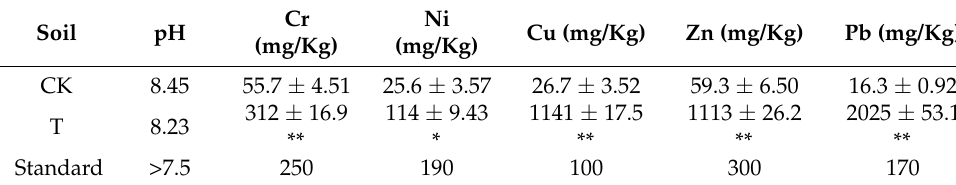
Table 1. Heavy metal content and Chinese National Standards. Soil pH